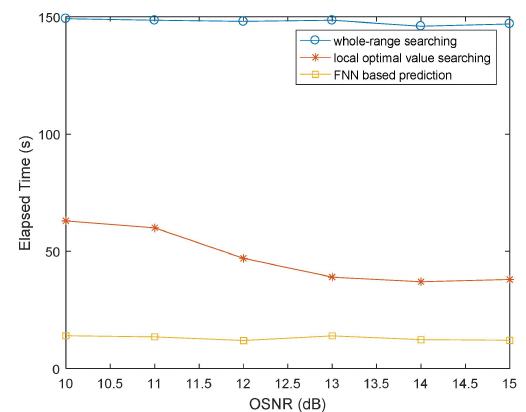
Figure 13. Average elapsed time of the search procedure when the OSNR